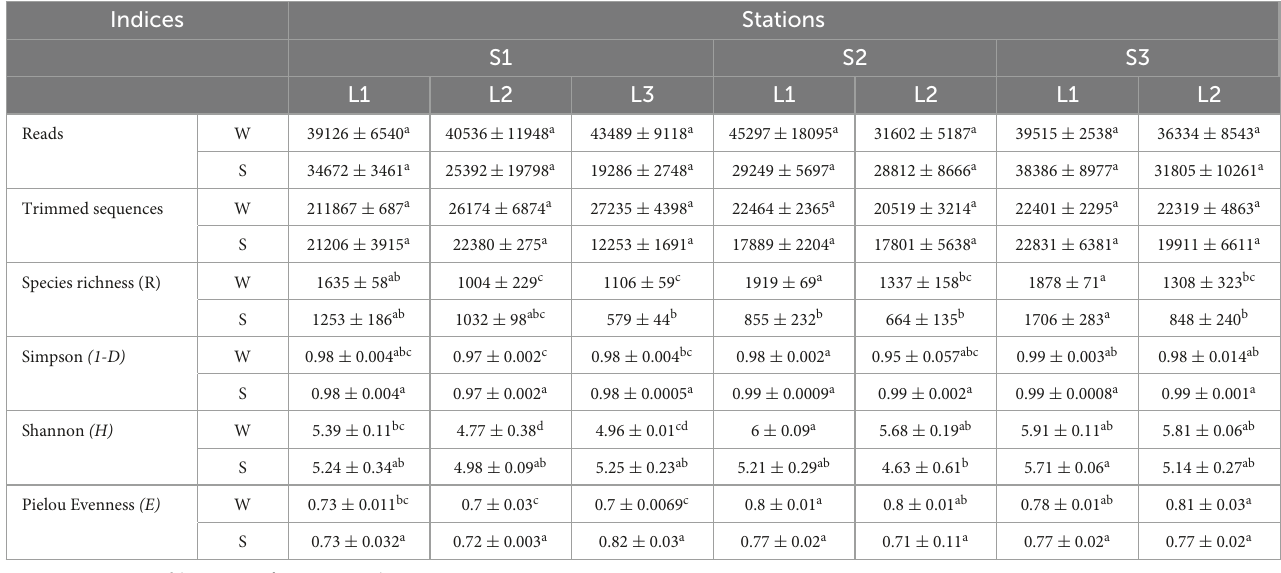
TABLE 1 Alpha diversity indices of prokaryotic community from the study sites located at the stations S1, S2, and S3 in Salineta wetland in winter (W) and summer (S) in different layers (L1, L2, and L3). Indices